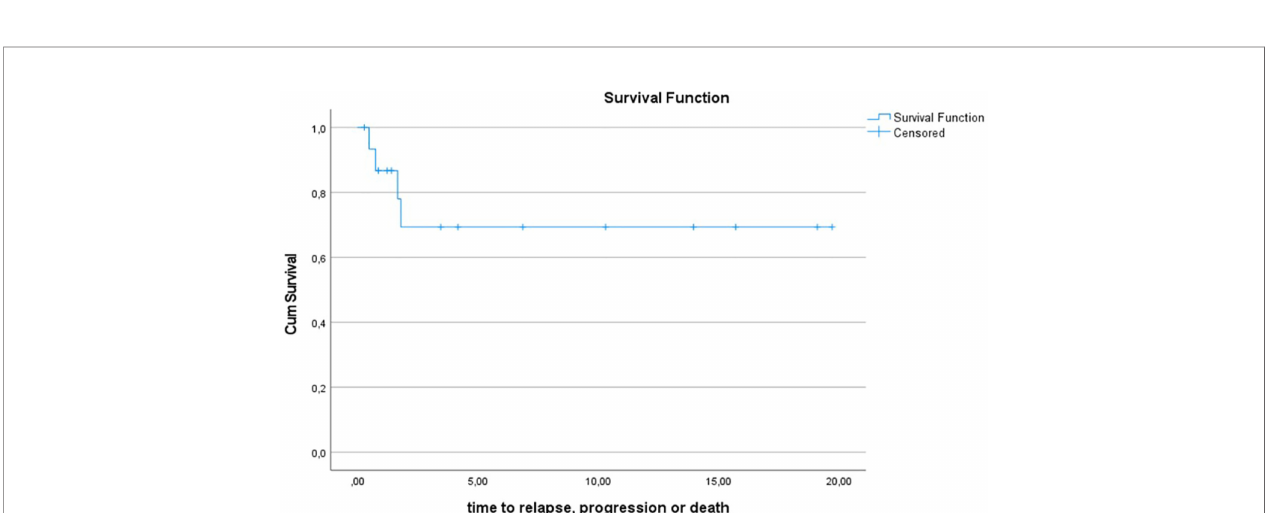
FIGURE 4.2 | Kaplan-Meier plot PFS for all patients with Gorlin syndrome